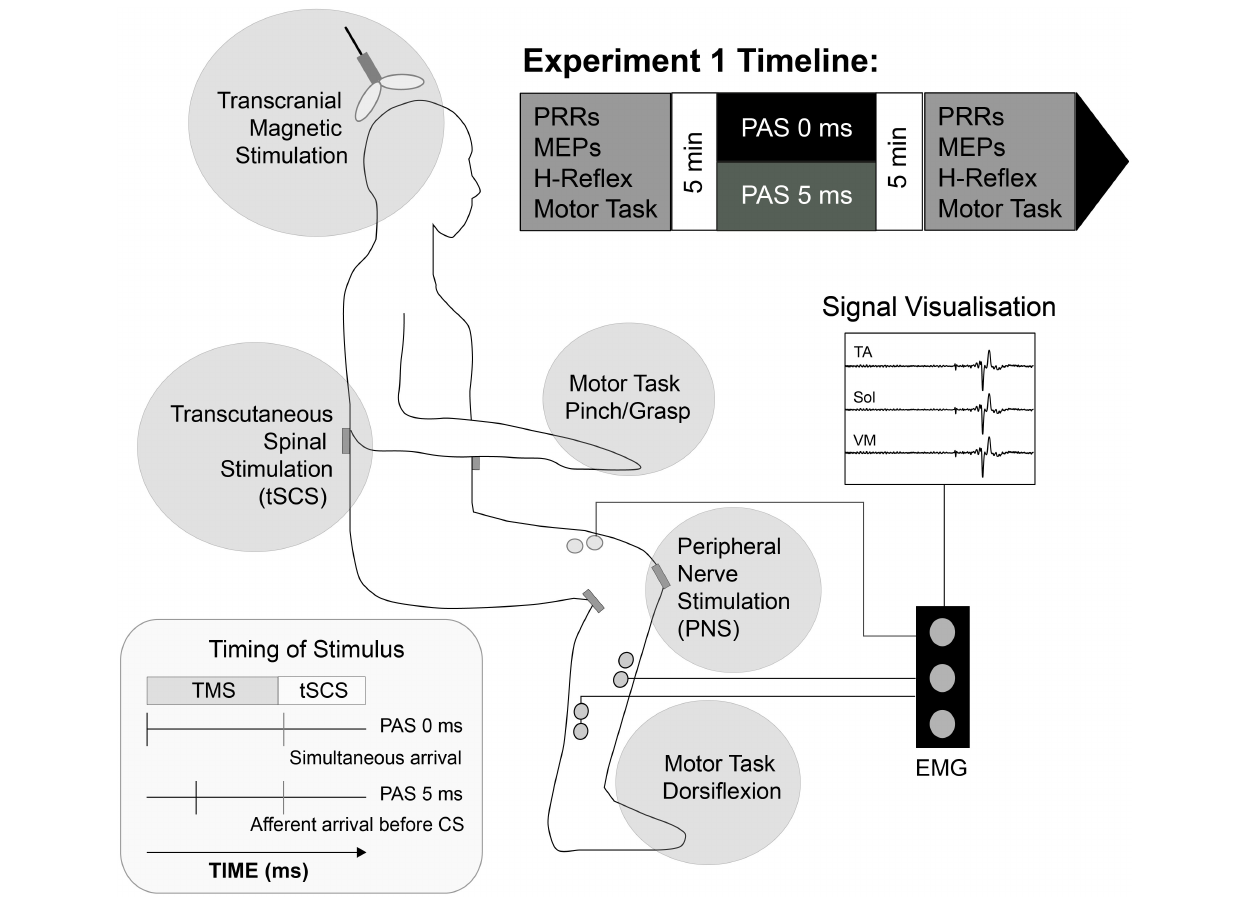
FIGURE 1 | Schematic representation of Experiment I setup. Transcutaneous stimulating electrodes were placed paravertebral at landmarks over T12/L1 to L3/4 spinous processes (tSCS) and the popliteal fossa (PNS). Pairs of surface EMG electrodes were placed over tibialis anterior (TA), soleus (Sol) and Vastus Medialis (VM) muscle groups bilaterally and corticospinal (MEPs), spinal (PRR), peripheral (H-Reflex) activity and motor task response (Force) was evaluated 5 min before and after selected Paired Associative Stimulation (PAS) protocol. PAS lasted ∼ 14 min, and consisted of 100 pairs of transcranial magnetic stimuli applied to leg motor cortex and non-invasive, transcutaneous spinal cord stimuli to participants in the seated